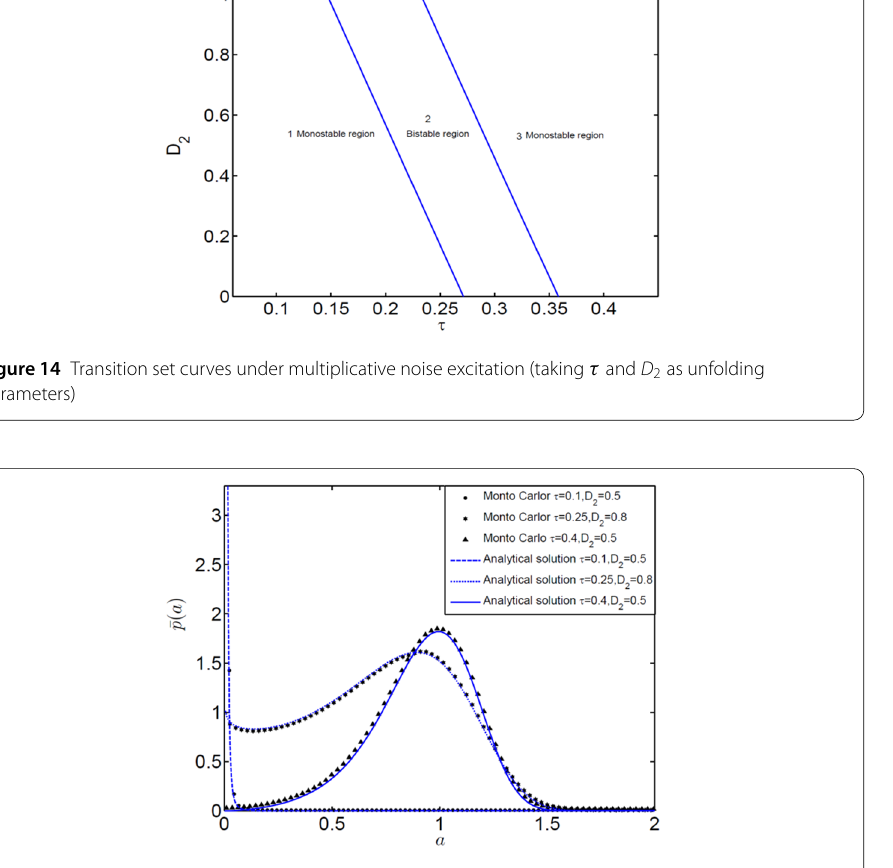
Figure 15 PDFs for ¯ p ( a ) under multiplicative noise excitation (taking τ and D 2 as unfolding